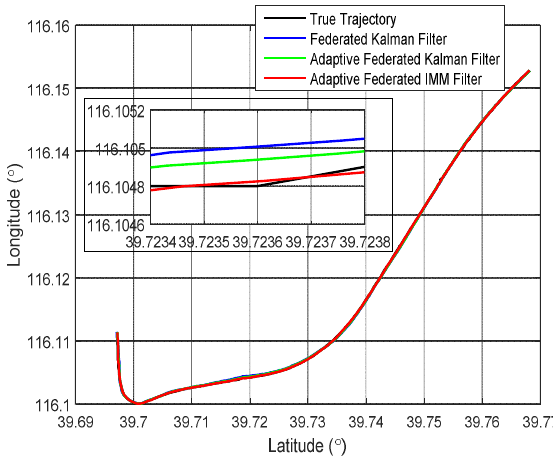
Figure 6. The estimation trajectories of the integrated navigation experiment.